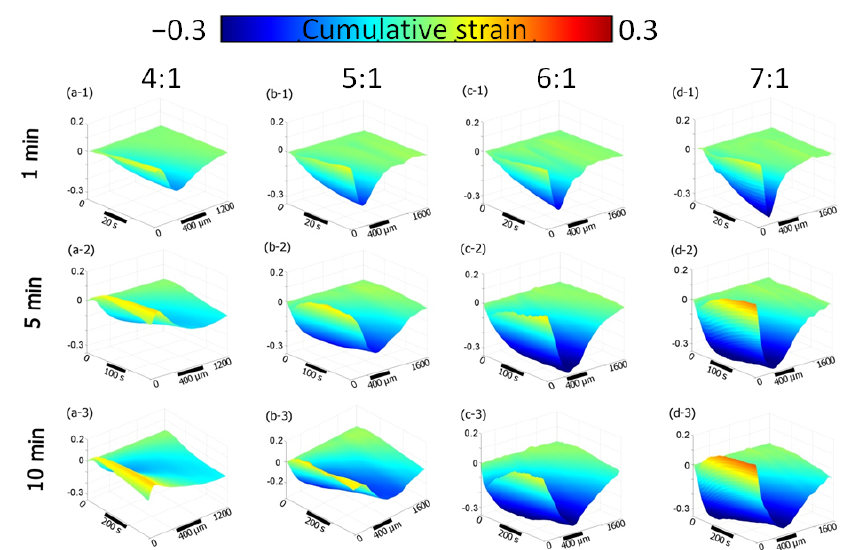
Figure 3. “Waterfall” diagrams of strain distribution obtained with OCE for polyacrylamide gels with different crosslinking ratios during their immersion in 50% ( v / v ) water ‐ based glycerol solution. The diagrams show the strain evolution for different time periods: 1 min ( a ‐ 1 – d ‐ 1 ), 5 min ( a ‐ 2 – d ‐ 2 ) and 10 min ( a ‐ 3 – d ‐ 3 ). Blue corresponds to an increased shrinkage (negative ‐ signed strain) and yellow corresponds to dilatation (positive ‐ signed strain).